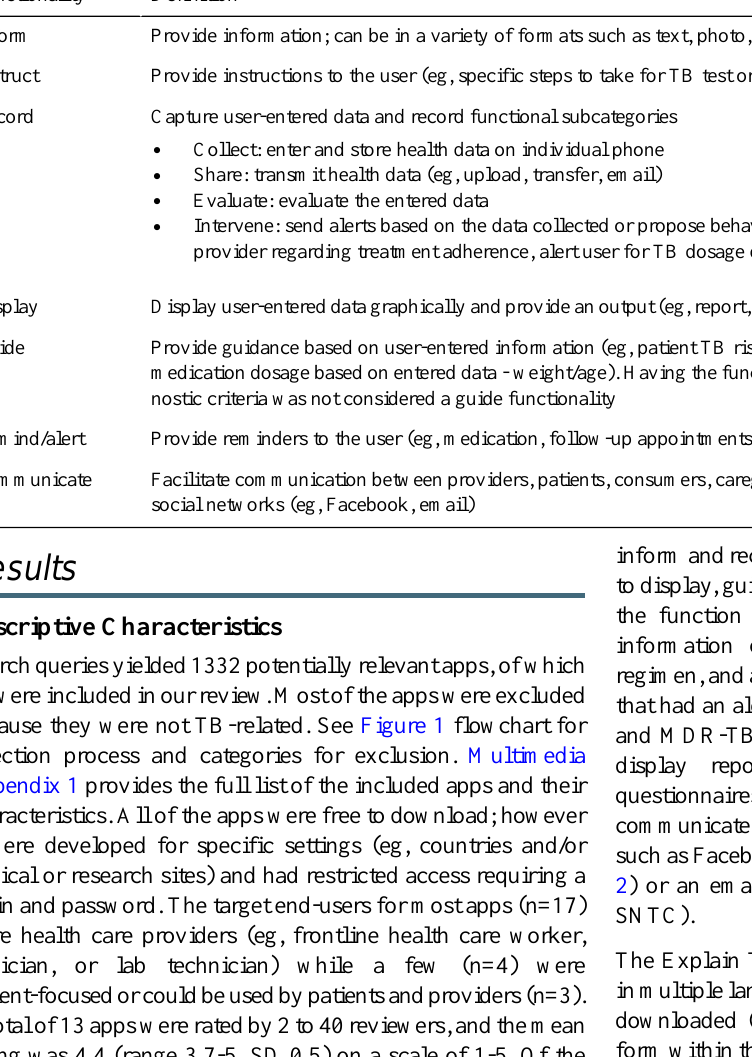
Table 1. App evaluation criteria.